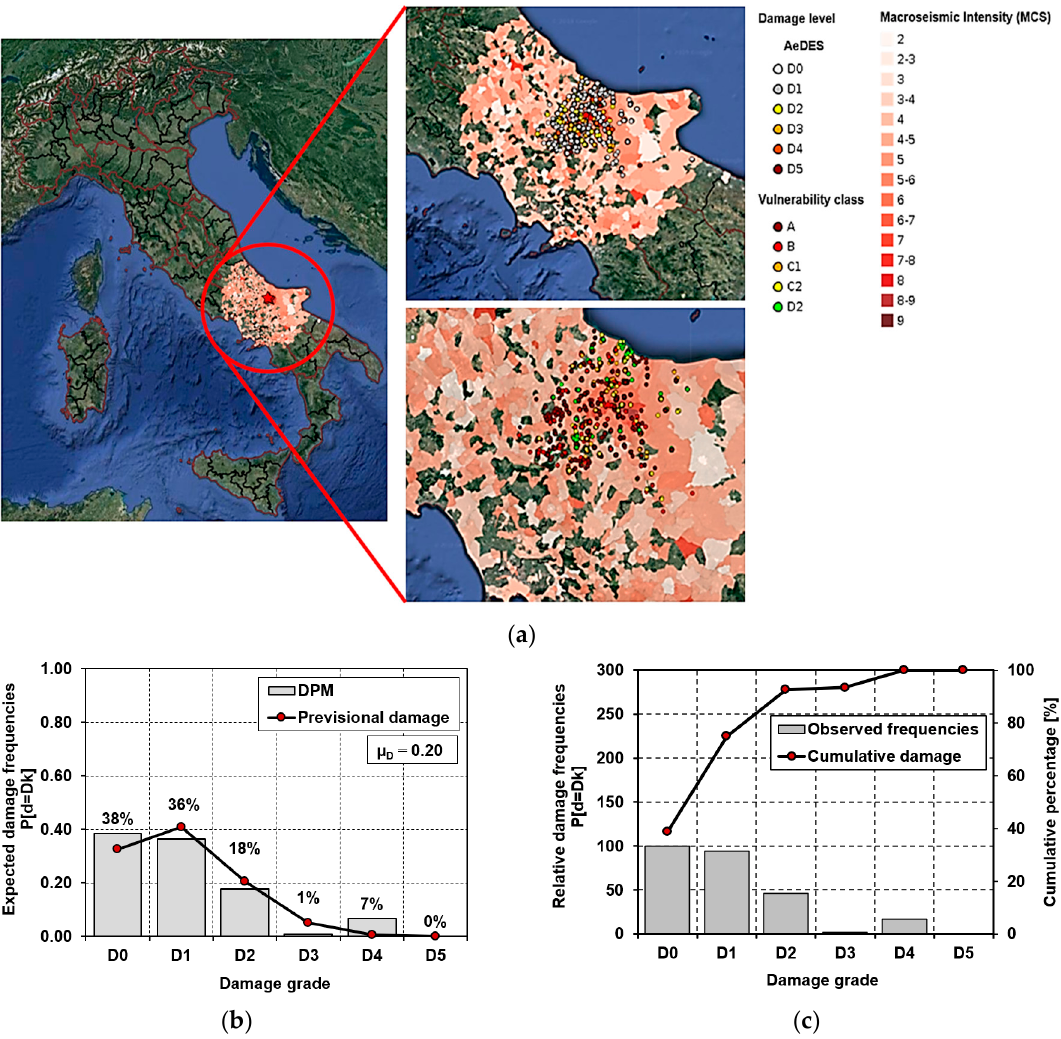
Figure 9. Damage observation: ( a ) Da.D.O database, ( b ) damage probability matrix and ( c ) cumulative damage distribution.